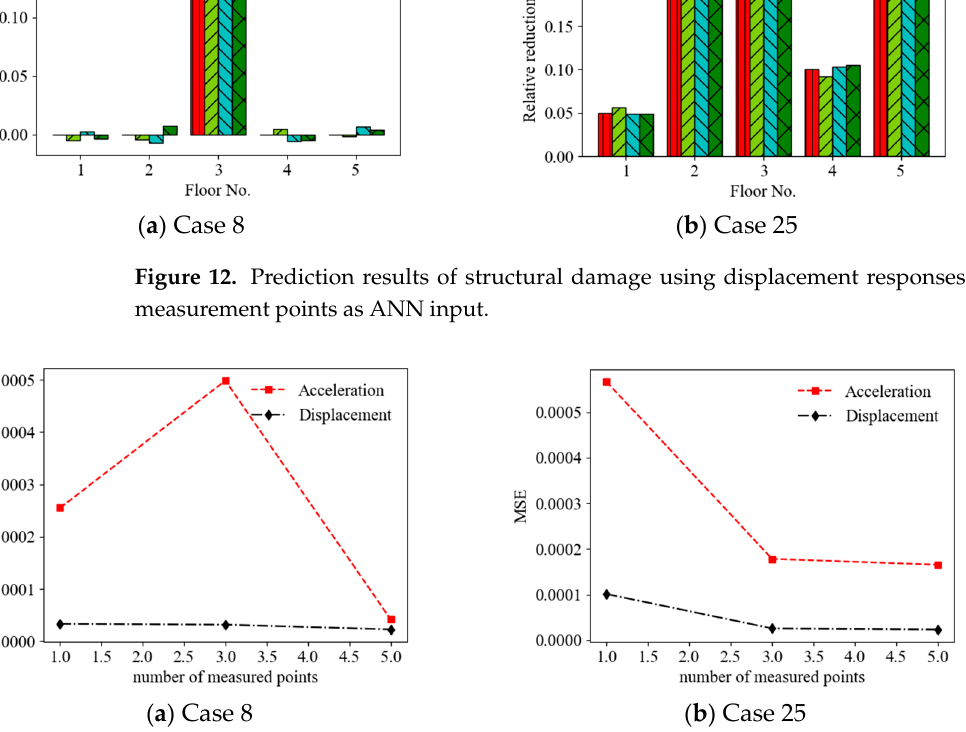
Figure 13. MSEs of prediction values versus number of measurement points using acceleration and displacement responses as ANN input.